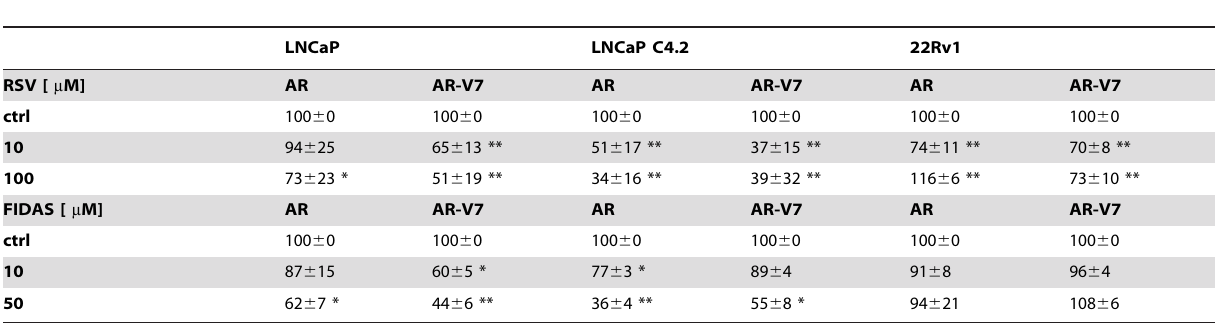
Table 3. Effects of RSV and FIDAS on AR- and AR-V7-mRNA-expression in prostate cancer cell